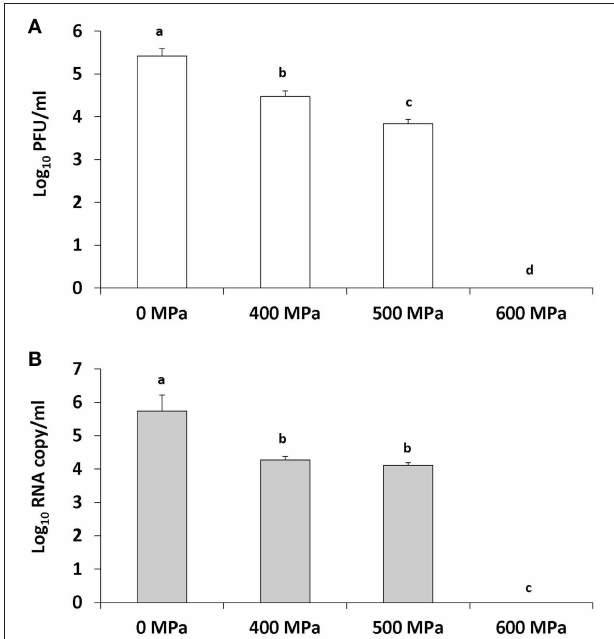
FIGURE 4 | TV inactivation in strawberry puree (pH 4) by increasing pressure levels as detected by plaque assay (A) and PGM-MB coupled with RT-qPCR (B) . Treatment is at an initial temperature of 4 ◦ C with a holding time of 2min. Each bar represents average of three replicates ± 1 standard